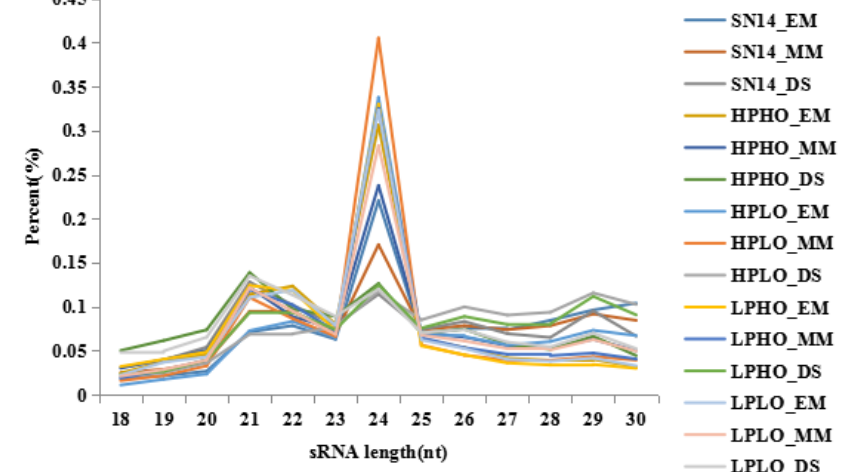
Figure 1. Statistics of small RNA strand length distribution. Small RNAs with materials [Suinong 14 (SN14), High Protein Low Oil (HPLO), Low Protein High Oil (LPHO), Low Protein Low Oil (LPLO), High Protein High Oil (HPHO)] in three stages [Early Maturity Stage (EM), mid seed maturity (MM), dry seed stage (DS) ] are shown in different color lines.